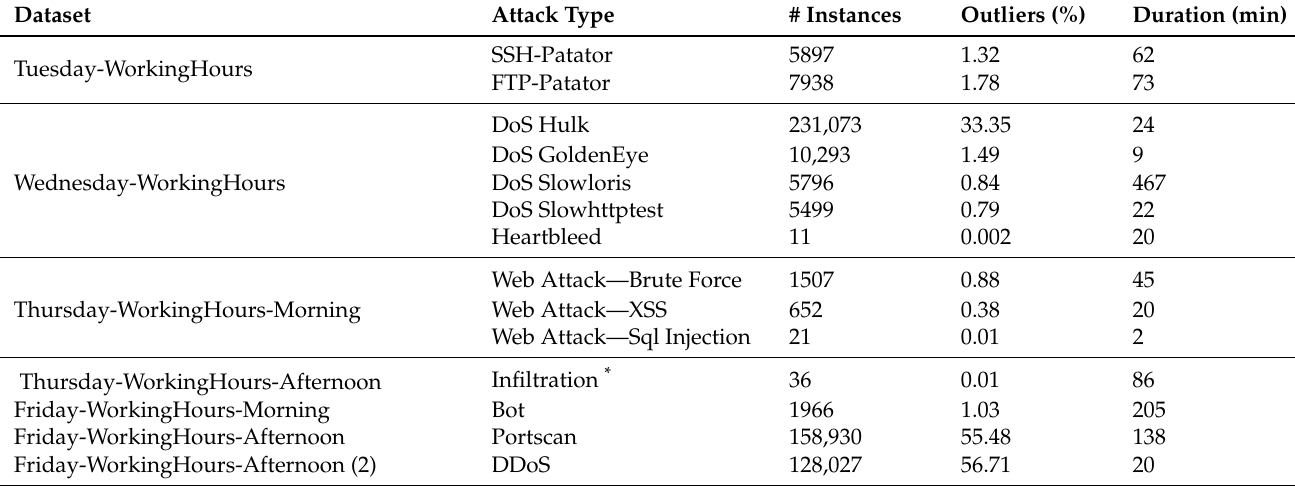
Table 2. The 14 different attacks with respective characteristics of the CICIDS2017